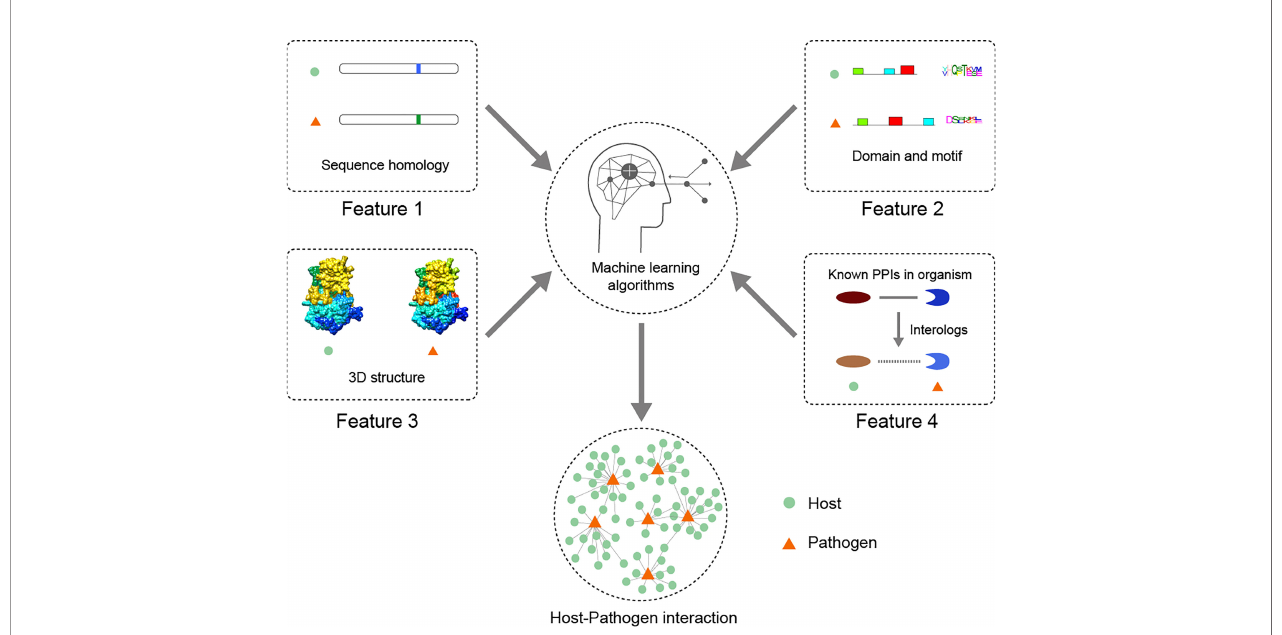
FIGURE 4 | In host-parasite interaction, four common features in a computational work fl ow are worth considering for which they can further improve the accuracy of prediction, including protein 3D structural information, domain-domain interaction and/or domain-motif interaction, and interologs based on the known PPI in an